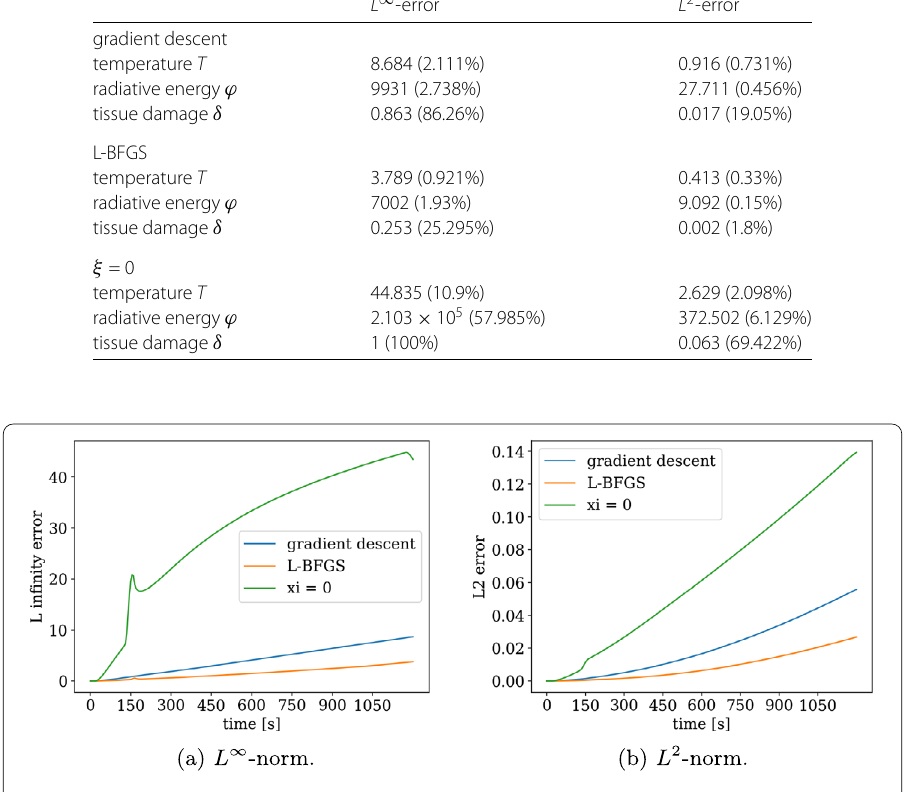
Figure 5 Evolution of the error in temperature over time for one